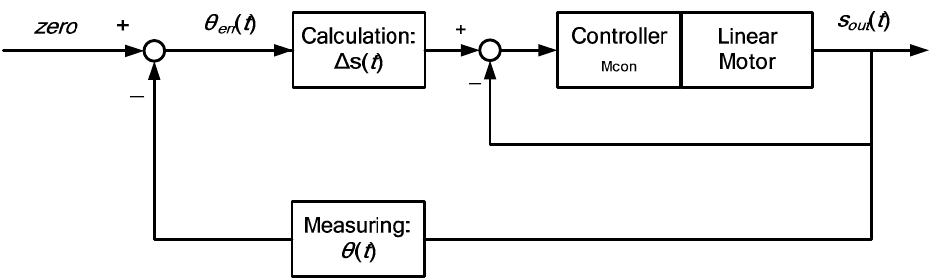
Figure 12. Position control block diagram for a linear actuator.